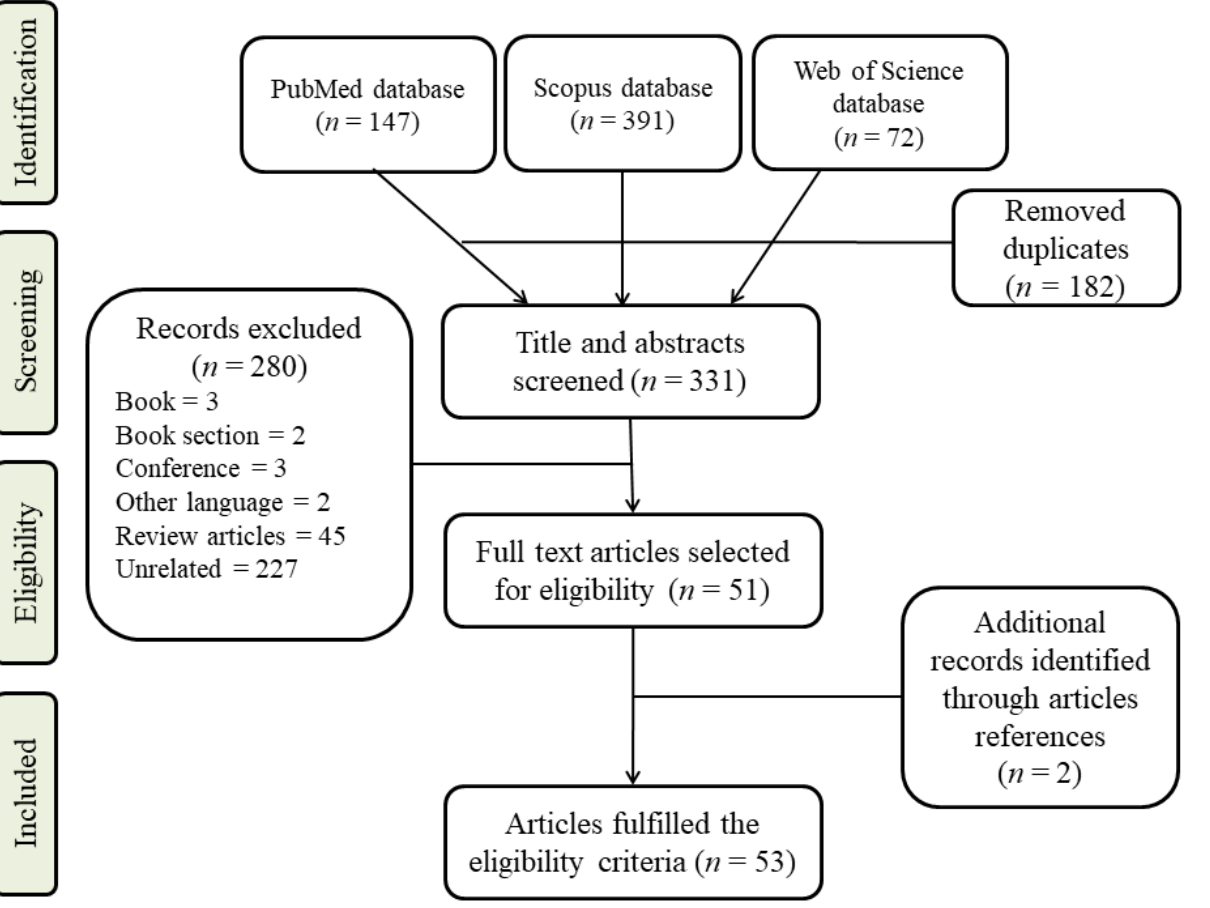
Figure 1. Flow diagram illustrating the process of identifying, screening, and selecting relevant studies. studies.